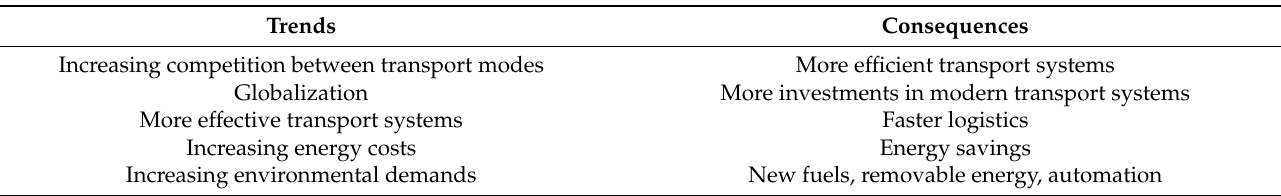
Table 1. Key markets drive influence on optimization transport systems and consumption of energy